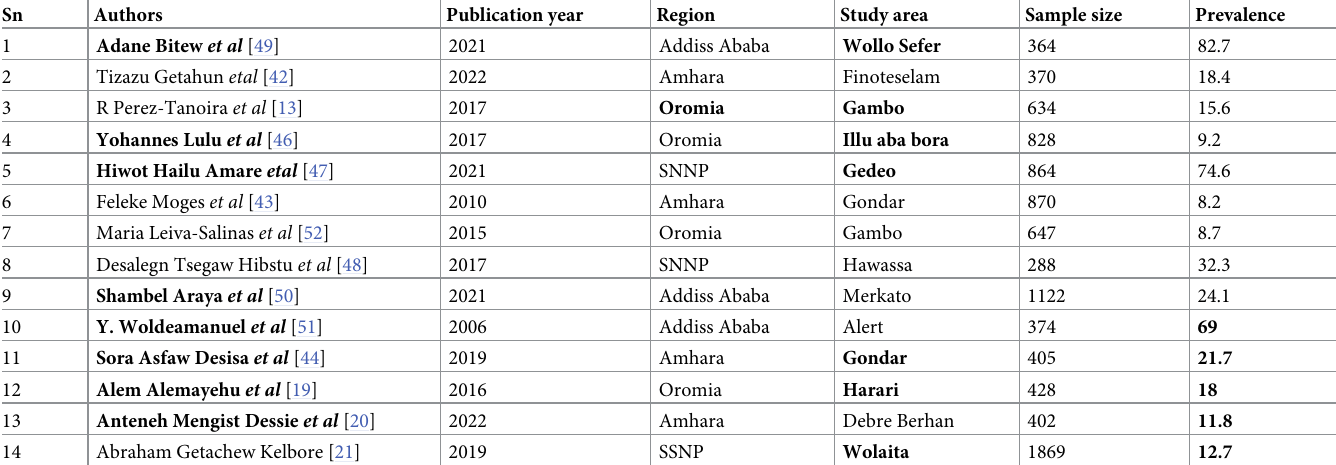
Table 1. The characteristics of the studies included in tinea capitis among Ethiopian schoolchildren.